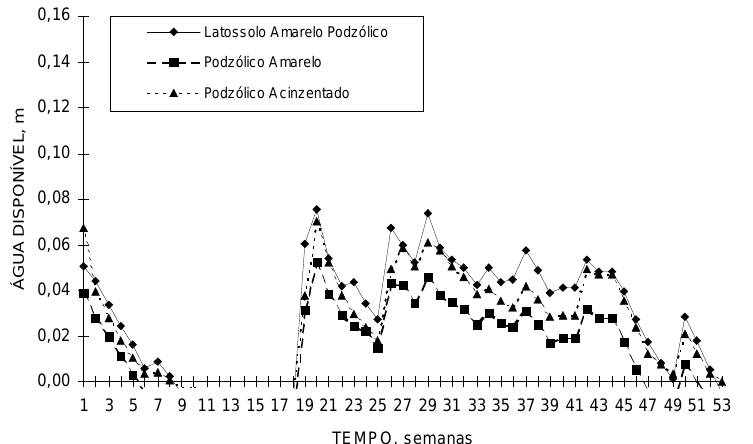
Figura 6. Água disponível até 0,90 m de profundidade, durante o período de um ano, a partir de 18 de dezembro de 1995, em uma toposseqüência de solos de tabuleiro cultivados com citros, no município de Sapeaçu